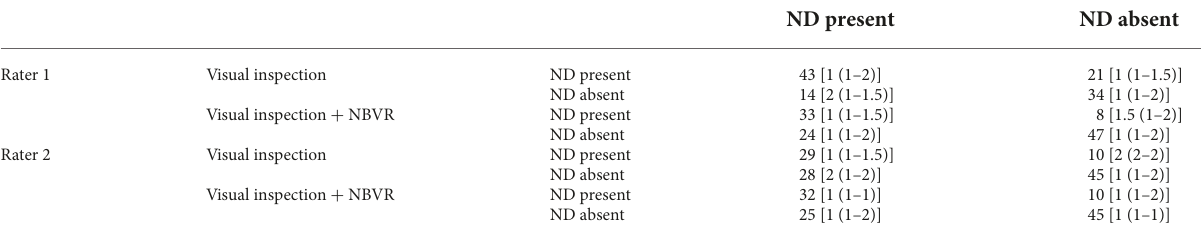
TABLE 2 Identification of individuals with and without atrophy patterns suggestive of neurodegenerative disease.